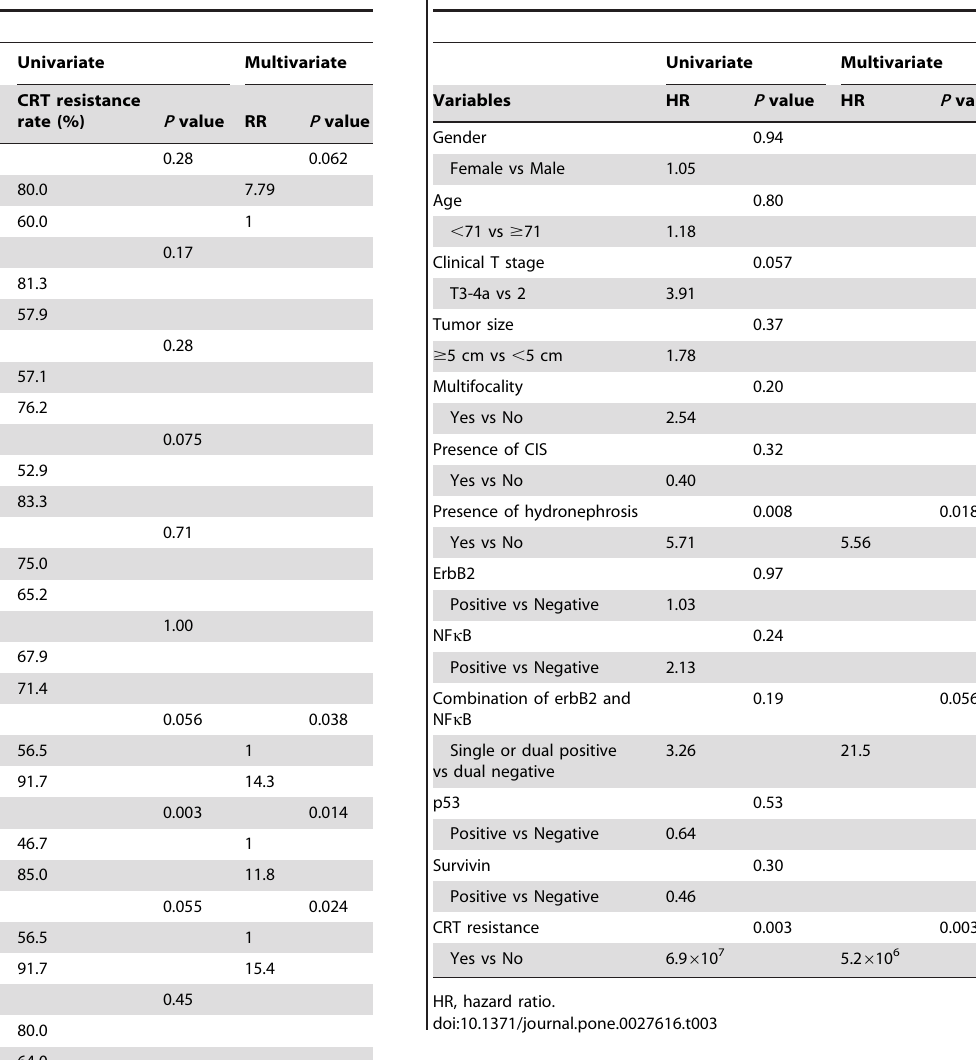
Table 2. Risk factors predicting CRT resistance. Table 3. Risk factors predicting bladder cancer